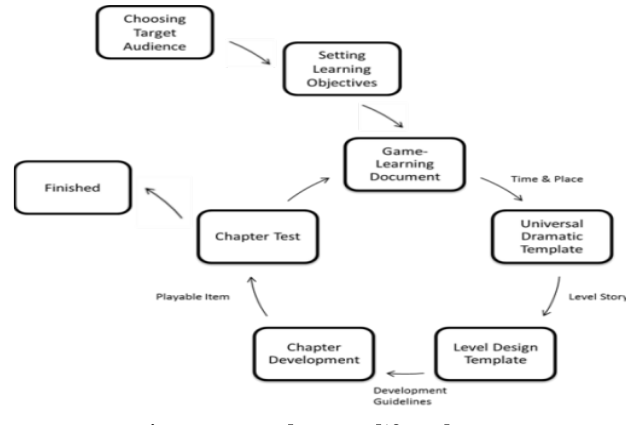
Figure 1. Development lifecycle